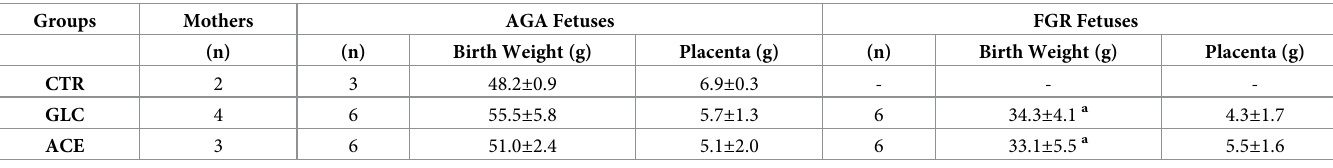
Table 1. Animal cohort used for HRMAS